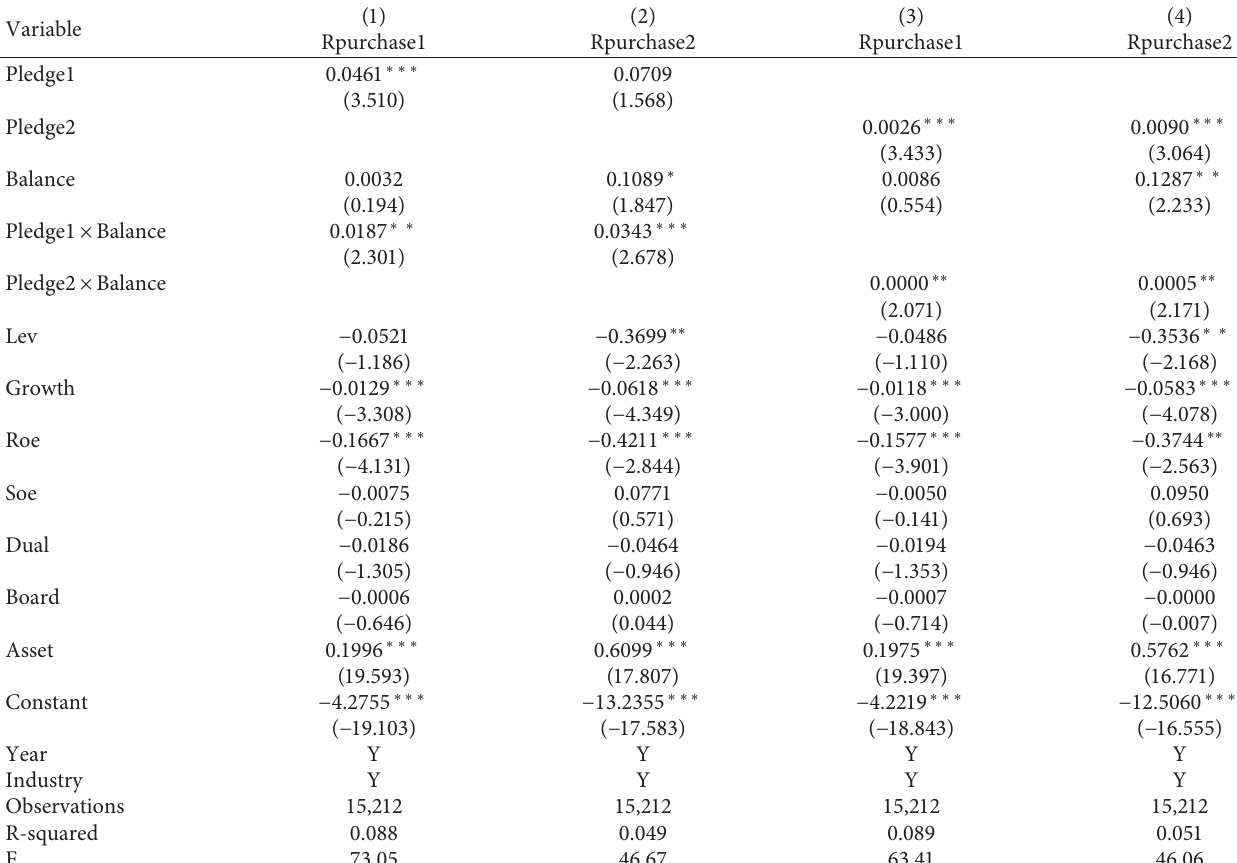
Table 10: Test results of controlling shareholders’ equity pledge, corporate governance, and listed companies’ stock repurchase.